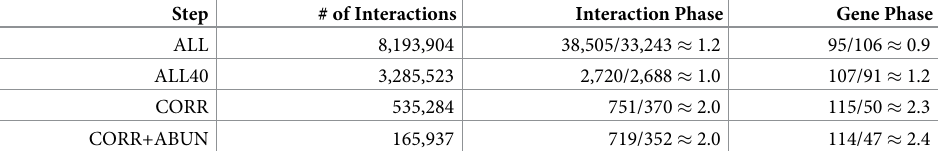
Table 4. Evaluation of miRNA-target interaction filtering steps for the computed miRNA-target interactions based on miRNA-protein expression anticorrelation. Step # of Interactions Interaction Phase Gene Phase ALL 8,193,904 38,505/33,243 � 1.2 95/106 � 0.9 ALL40 3,285,523 2,720/2,688 � 1.0 107/91 � 1.2 CORR 535,284 751/370 � 2.0 115/50 � 2.3 CORR+ABUN 165,937 719/352 � 2.0 114/47 � 2.4 Interaction phase shows the anticorrelated expressions of miRNA-protein target pairs with respect to positively correlated pairs. Gene phase shows the anticorrelated expression of target with average of all miRNA regulators with respect to the one having positive correlation. (Ratio is expected to be more than 1 to have anticorrelation tendency. Higher is better). See Table 1’s caption for the definition of row